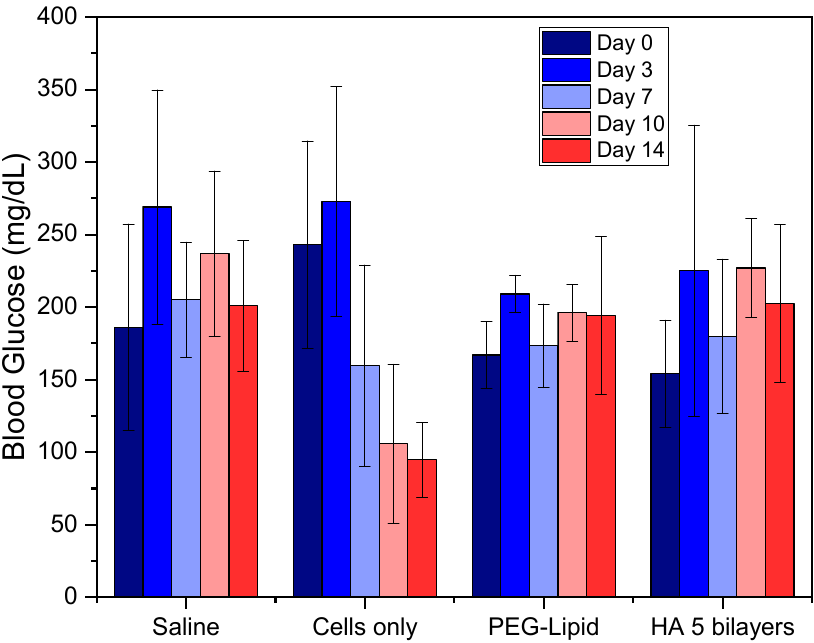
Figure 3. Post-transplantation blood glucose levels for mice groups euthanised at day 14. Sample size n = 5 for each group.